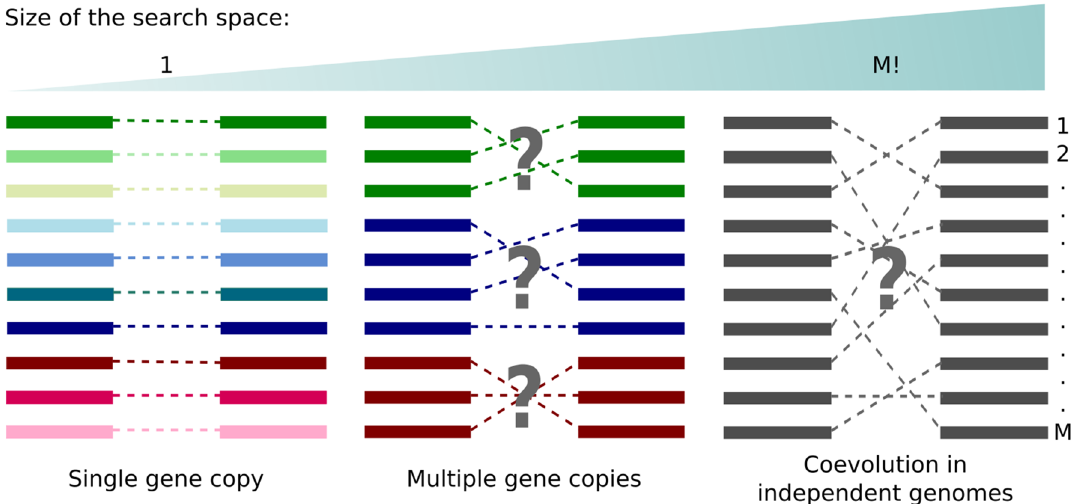
Figure 1. Different scenarios for protein partners determination from multi-sequence alignments. The correct set of partners is known for systems with a single gene copy per genome and unknown for systems involving multiple (paralogous) sequences within the same genome or multiple sequences across independent genomes. This figure was created with Inkscape (https:// inksc ape.